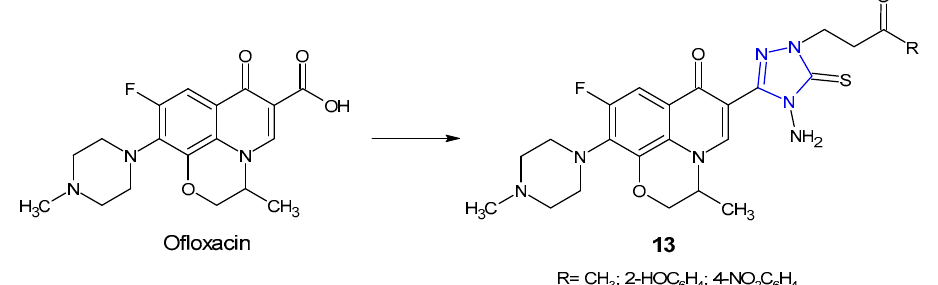
Figure 6. 1,2,4-triazole analogues of ofloxacin.